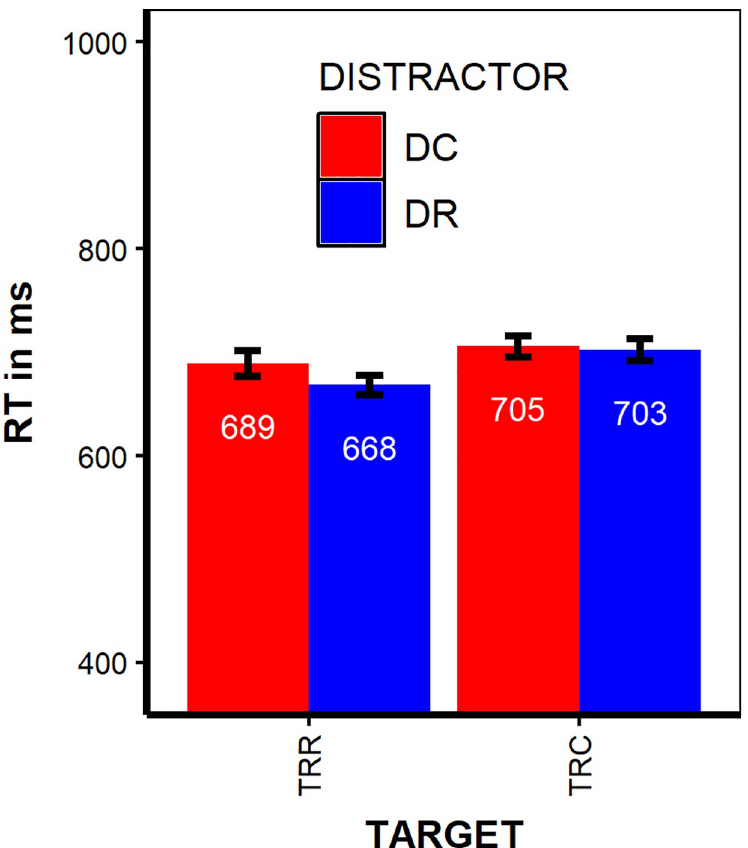
Fig 2. Reaction times. RTs separated by TARGET (TRR = Target Response Repetition, TRC = Target Response Change) and DISTRACTOR (DC = Distractor Change, DR = Distractor Repetition). Error bars indicate +/- 1